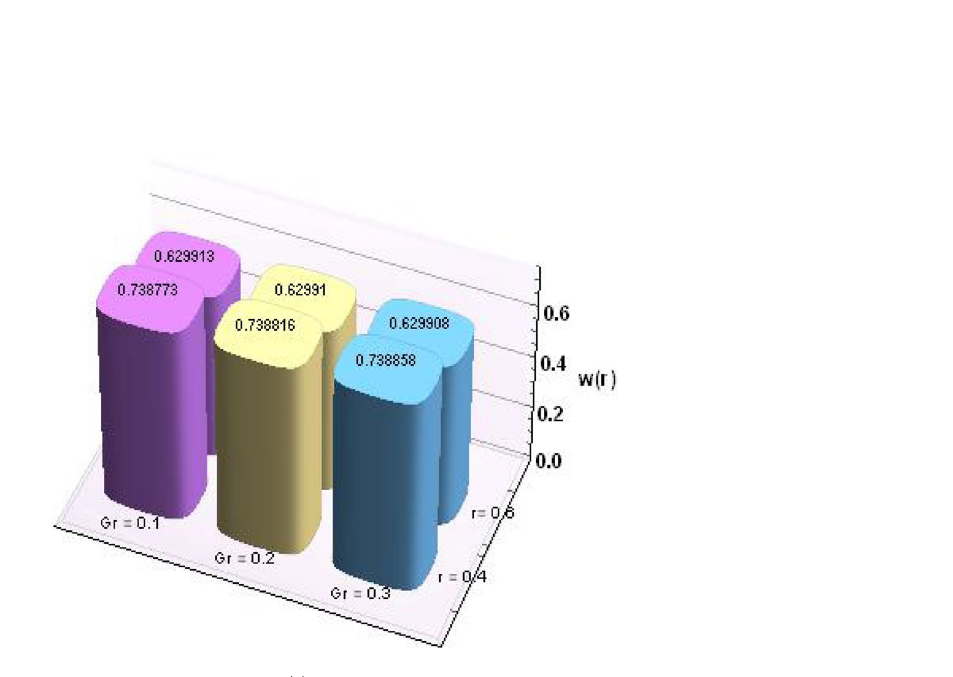
Figure 12. Variation in w(r) against Gr